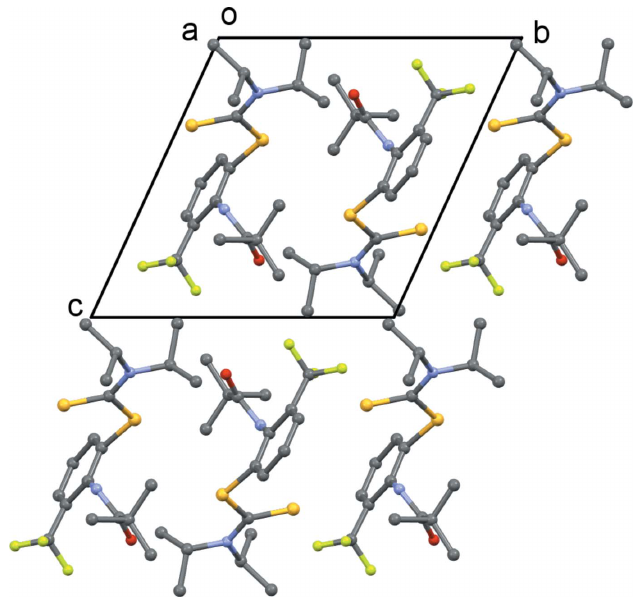
Figure 2 Crystal packing, viewed down [100]. Hydrogen atoms have been omitted for clarity.